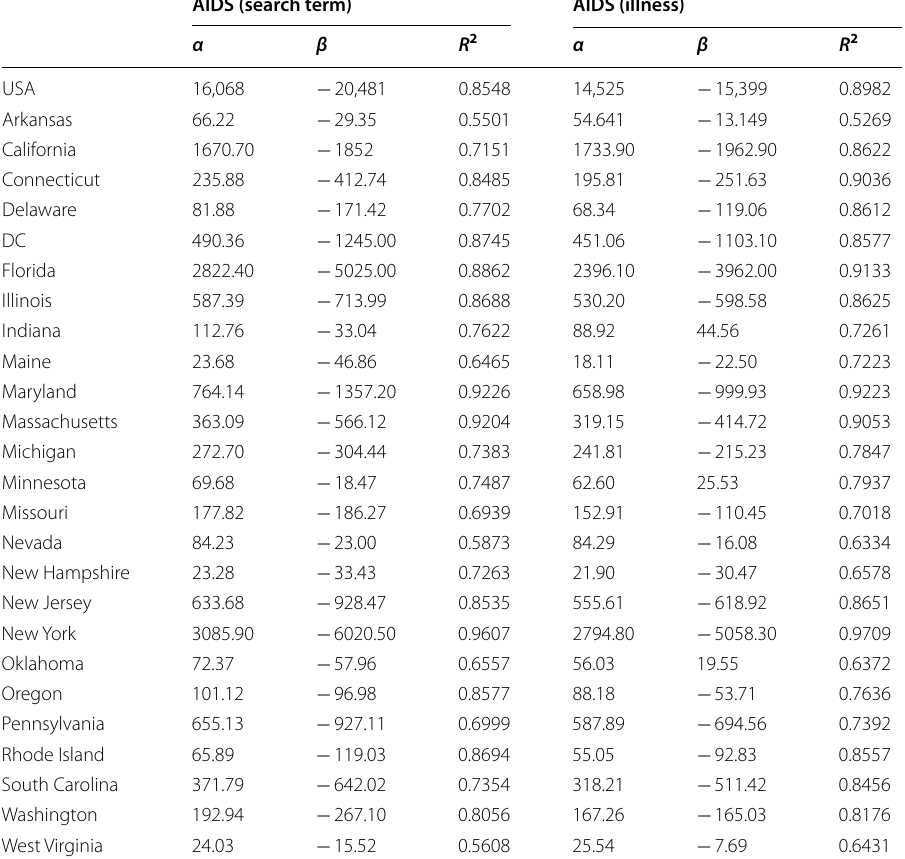
Table 6 Coefficients α and β , and R 2 for the estimated forecasting models for ‘AIDS